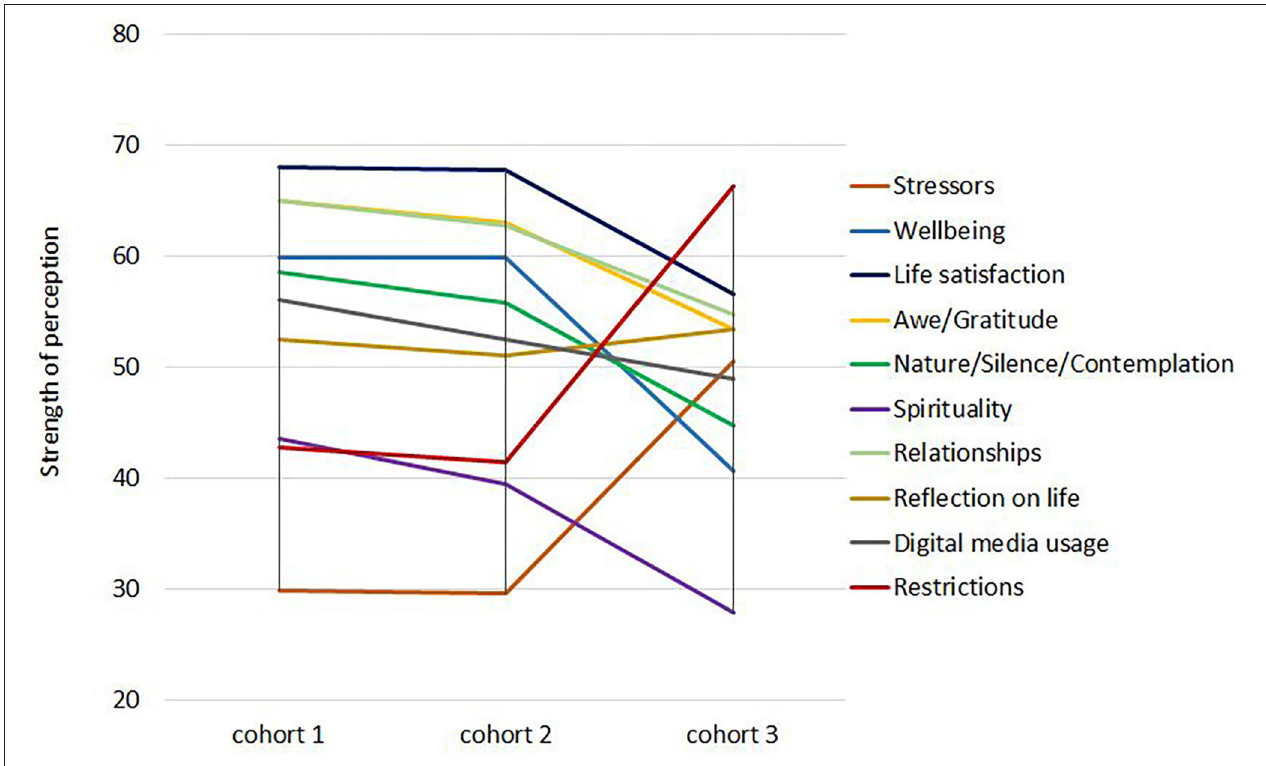
FIGURE 1 | Strength of perceptions in the three